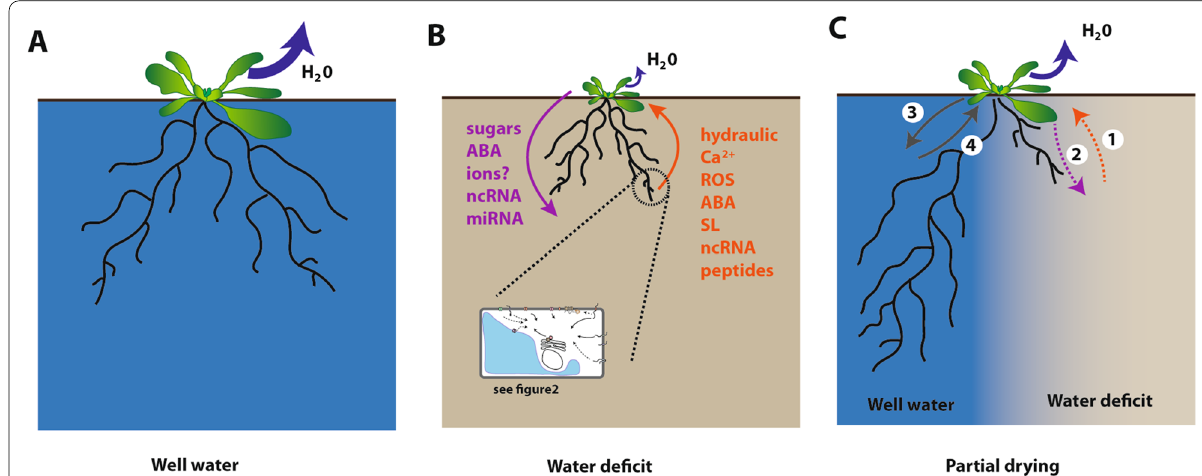
Fig. 3 Long-distance and developmental response to homogeneous or local water deficit. A Soil water is absorbed by roots and moves through xylem vessels to the leaves where it is eliminated via transpiration (blue arrow). B When plants experience water shortage, they first dramatically reduce transpiration and modify root and shoot growth according to water availability. Roots, which perceive locally the osmotic stress as described in Fig. 2, activate long-distance signaling (orange arrow) conveyed by hydraulic signals or a wide range of molecules, including calcium (Ca 2 + ), Reactive Oxygen Species (ROS), phytohormones (Abscisic Acid (ABA), Strigolactones (SL), etc), non-coding RNA (ncRNA) and peptides. In return, water deficit induces a shoot-to-root signaling (violet arrow) that relies on a set of molecules including sugars, ABA, ncRNA and micro RNA (miRNA). C When plants encounter a local water deficit also named partial root zone drying (PRD) in agronomy, the transpiration rate is reduced but not as severely as under a uniform water deficit. As a consequence, shoot development can be maintained or has a limited reduction depending on the intensity and duration of the local water deficit or on the plant developmental stage. Root growth in the drying part is strongly repressed whereas it is maintained or stimulated in the wet part through a compensatory growth stimulation. It was proposed that, during PRD, roots are sensing the local low water potential in the drying soil resulting in a reduction in cell turgor, then transmitting the signal to the shoot (arrow 1). In return, a shoot-to-root signal (arrow 2) represses root growth. Since root development and water uptake are stimulated in the well-watered part, the existence of both a shoot-to-root and a root-to-shoot signaling can be hypothesized (arrows 3 and 4). Besides ABA, the nature of other